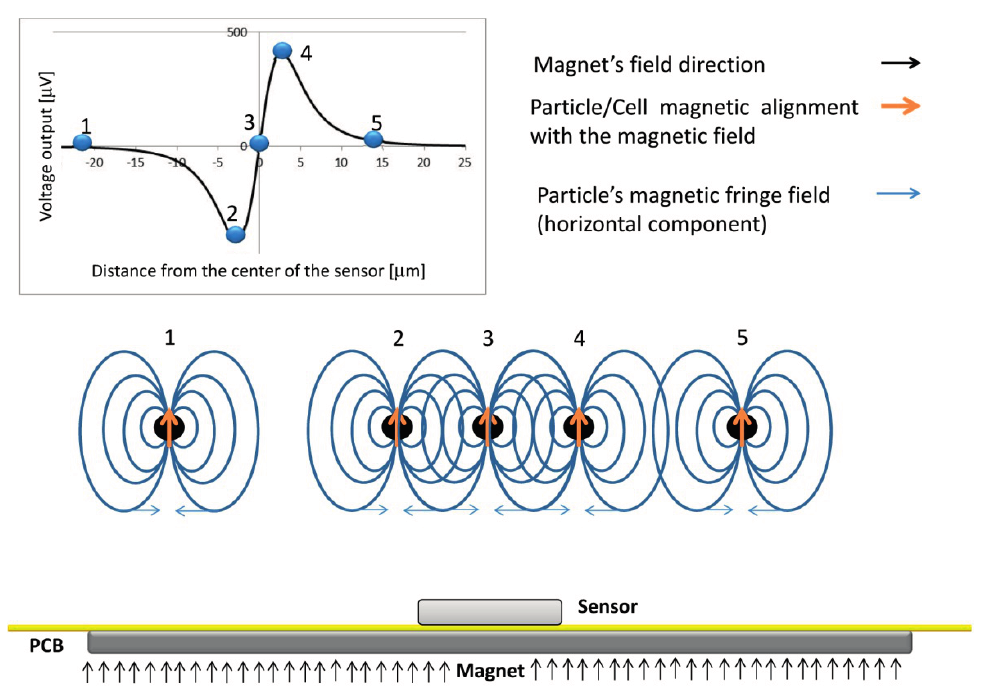
Figure 3. Schematics of MR sensor detection of magnetically labeled targets flowing above the sensor, from the left (position 1) to the right (position